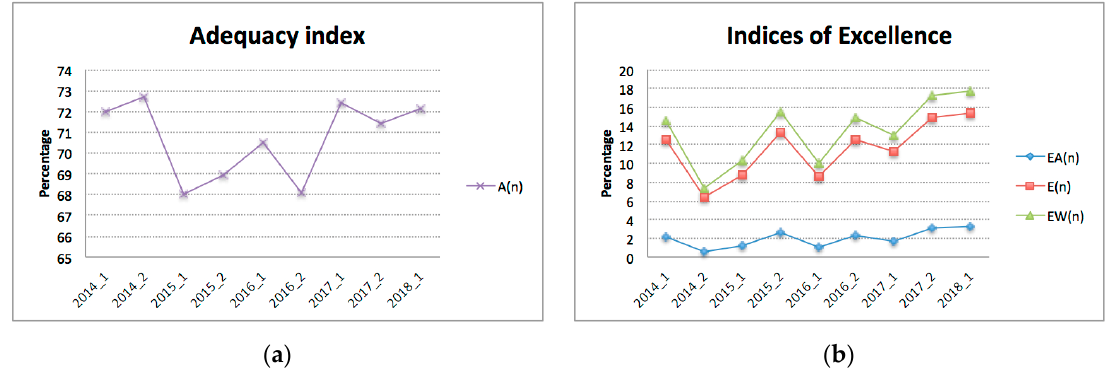
Figure 4. Adequacy ( a ) and excellence ( b ) indices expressed in Table 5.